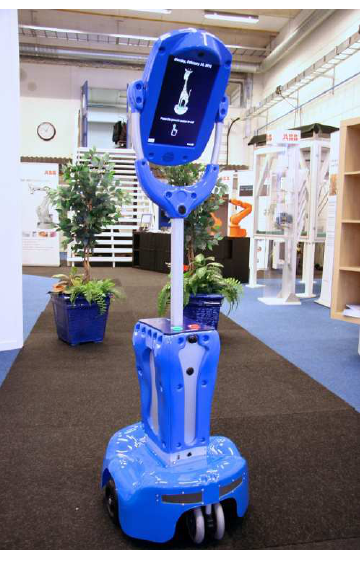
Figure 1. Giraff robot.